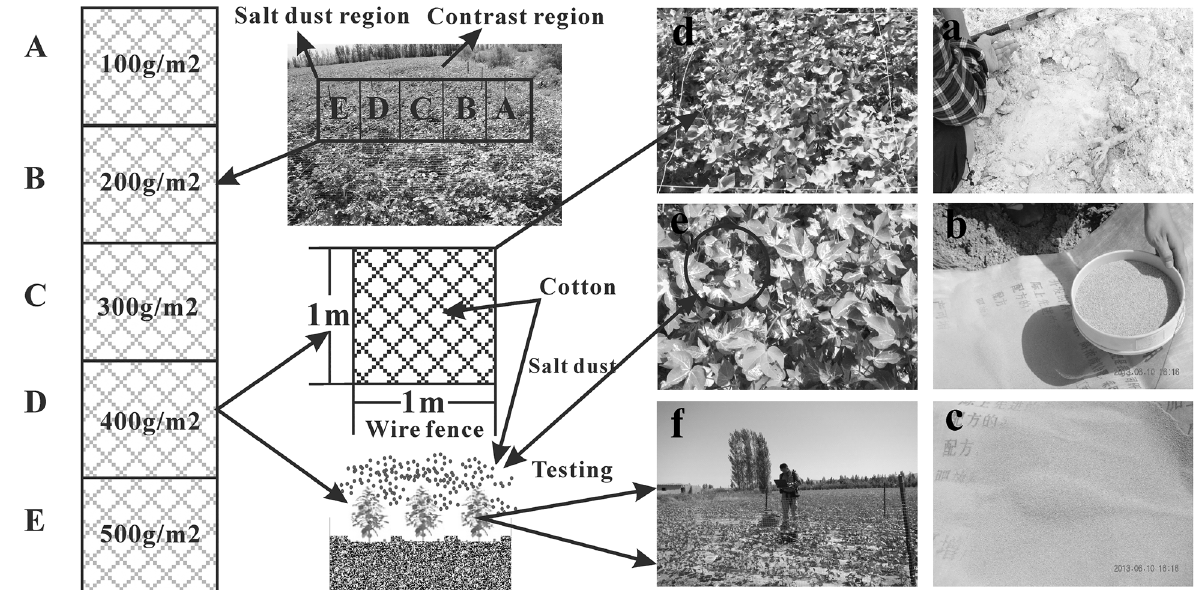
Fig 2. Setup of simulation